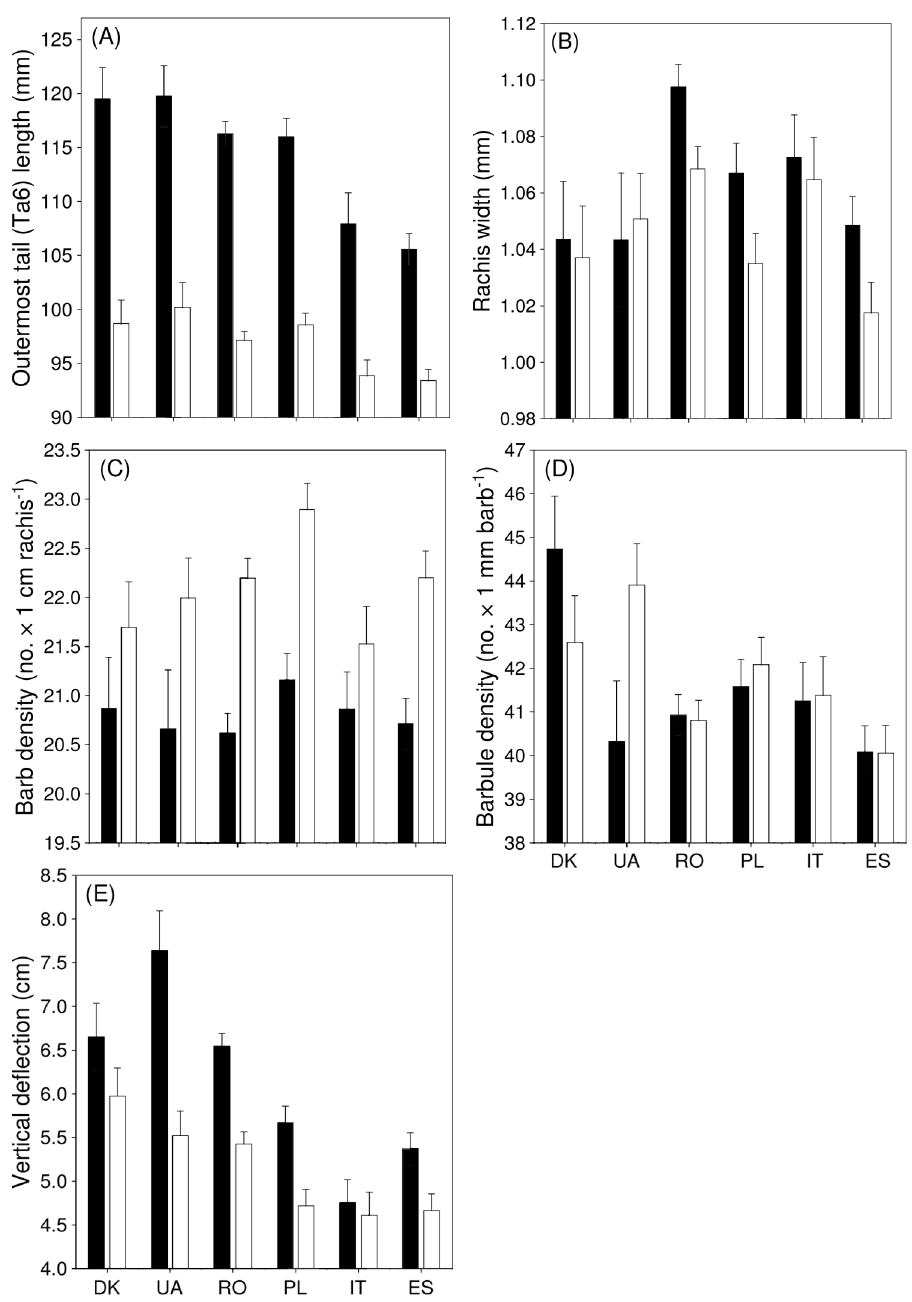
Fig 4. Variation in feather quality traits of Ta6 in male (black) and female (white) barn swallows from six European populations (DK — Denmark, UA — Ukraine, RO — Romania, PL — Poland, IT — Italy, ES — Spain) (mean +